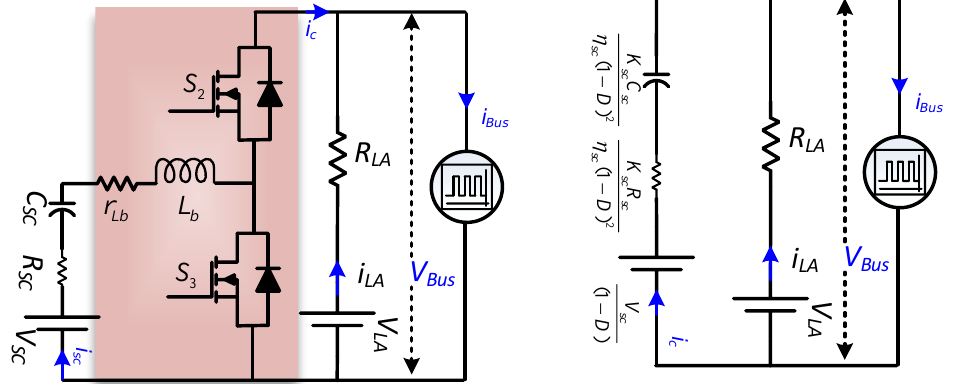
Figure 8. The SC semi-active HESS equivalent circuit.